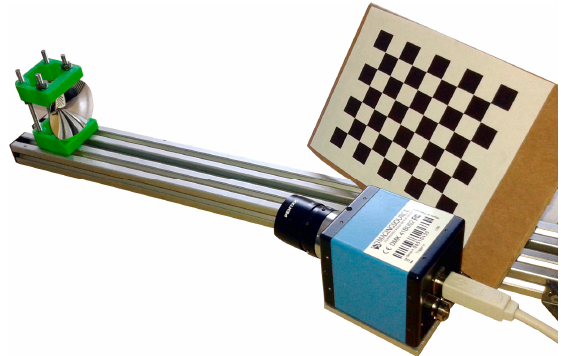
Figure 5. Catadioptric system with the planar chessboard pattern used for the experimental tests.